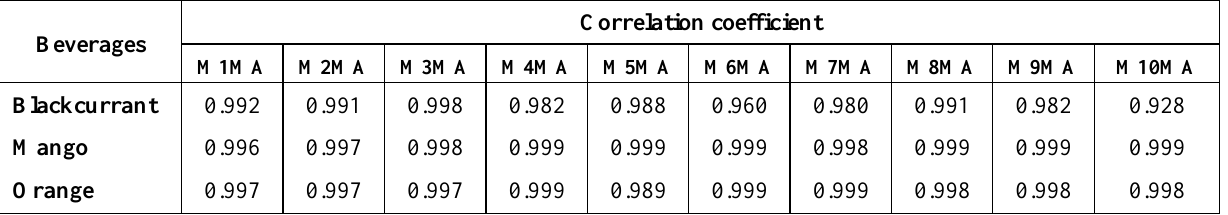
Correlation coefficient